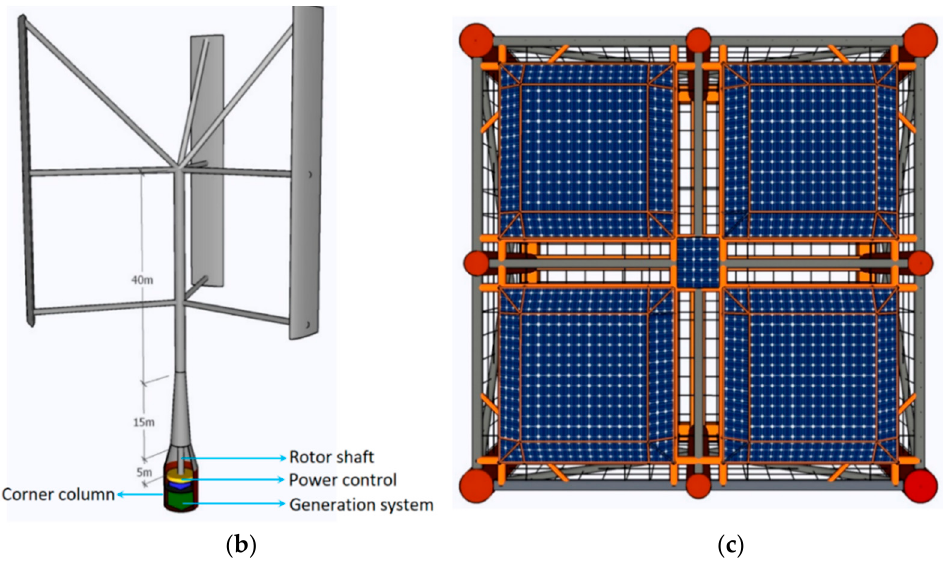
Figure 1. Concept of the wind–solar–aquaculture system (WSA): ( a ) perspective diagram of the WSA structure; ( b ) straight-bladed vertical-axis wind turbine (VAWT); ( c ) arrangement of the solar array—top view.